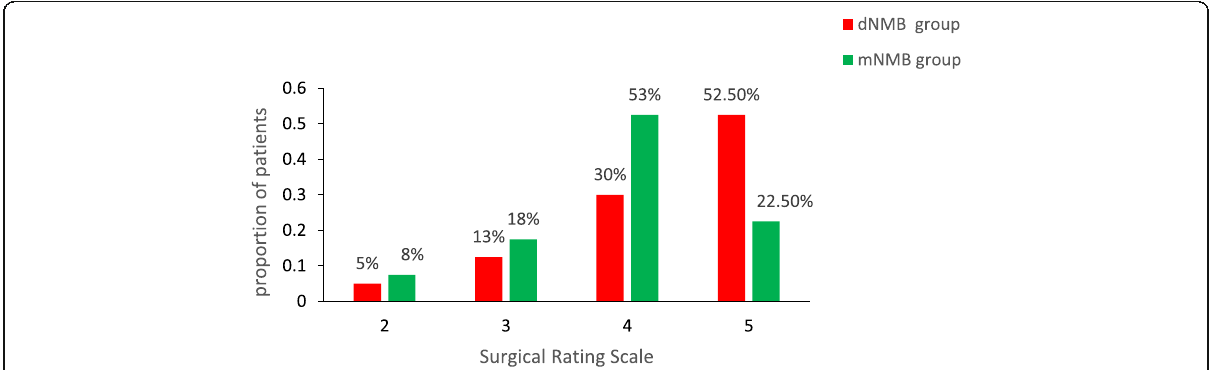
Fig. 2 Proportion of patients distribution over surgical rating scale (SRS) scores in both groups. dNMB, deep neuromuscular block; mNMB, moderate neuromuscular